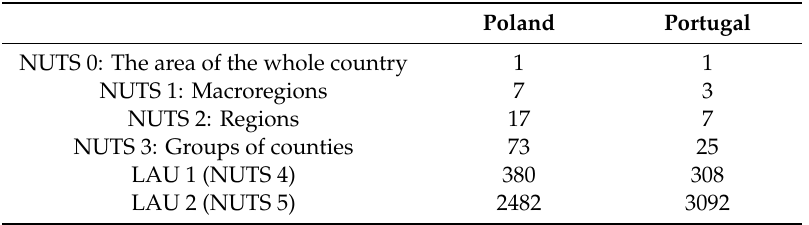
Table 2. NUTS and LAU classification for Poland and